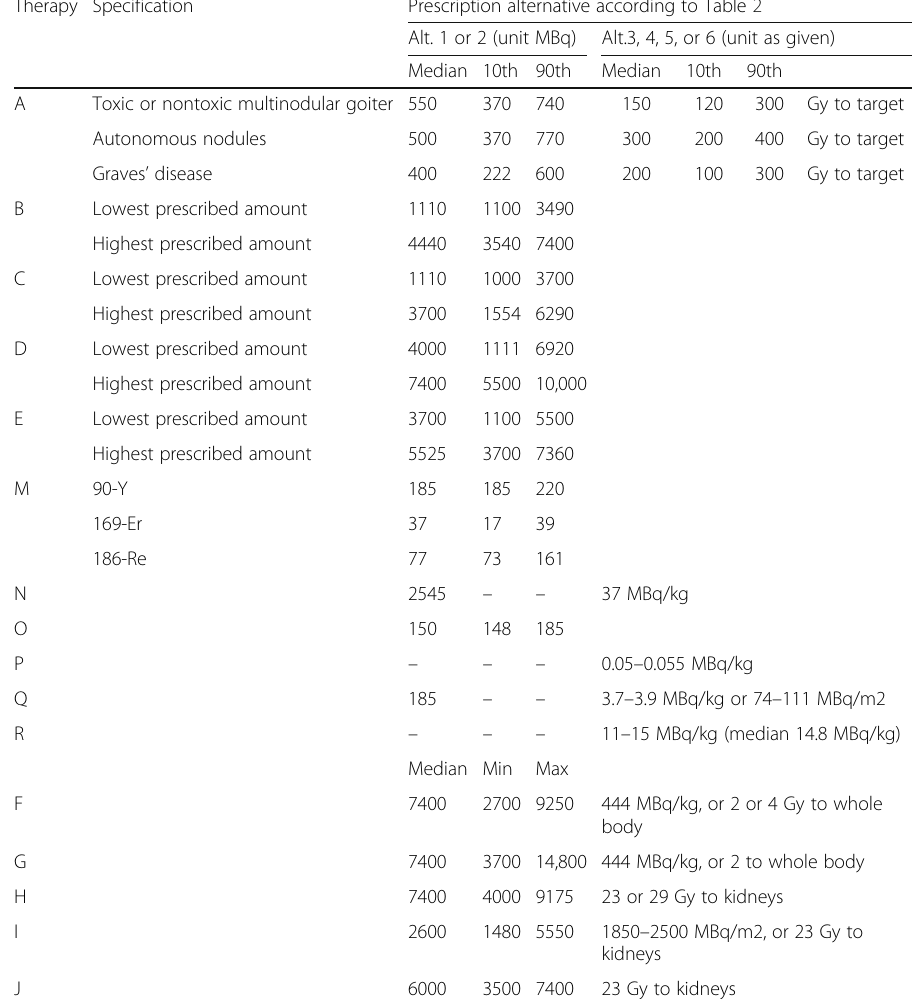
Table 4 The most commonly stated prescribed amounts for the different therapies. Therapy notations follow Table 1, whereas prescription alternatives 1 – 6 refer to Table 2. The prescribed amounts are given either as median, 10th and 90th percentiles, or as median, minimum, and maximum, depending on the replies obtained. The percentiles are used to better accommodate some occasional outlier